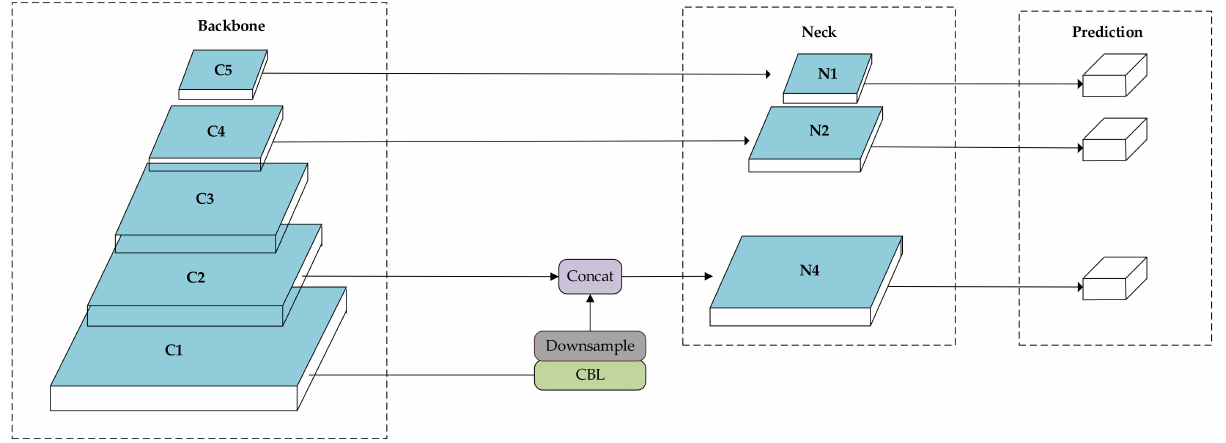
Figure 4. Overview of multi-scale cross-layer detectors and feature fusion